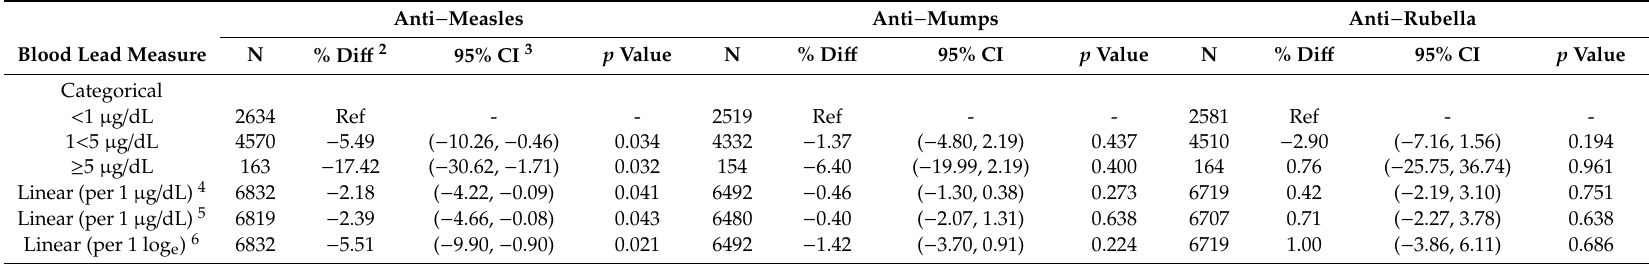
Table 2. Adjusted 1 percent change in seropositive anti-measles, anti-mumps, and anti-rubella levels in relation to child blood lead